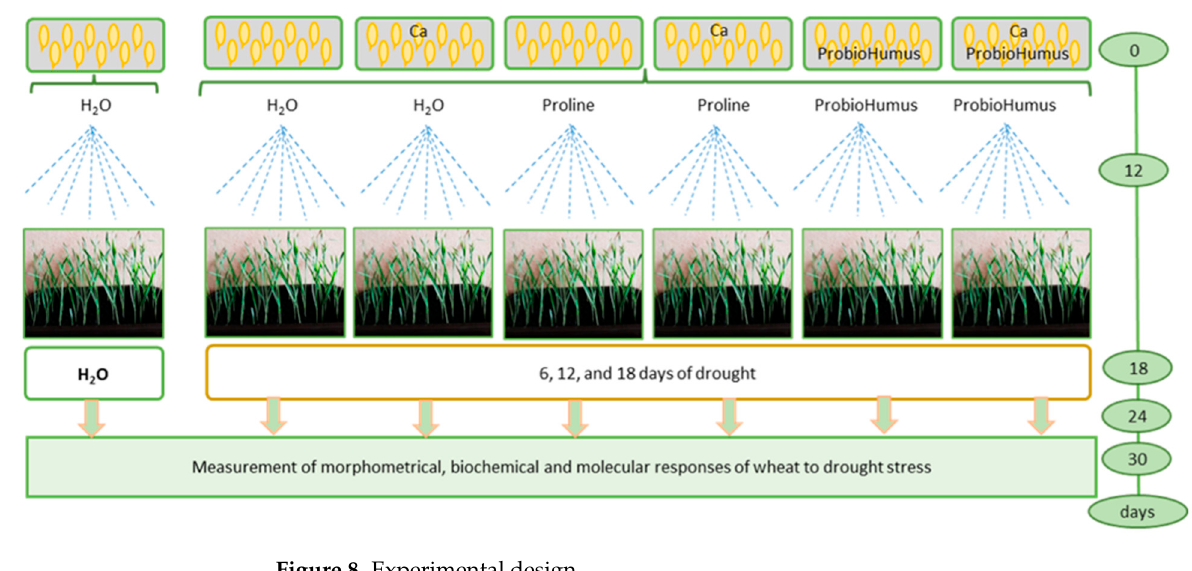
Figure 8. Experimental design.